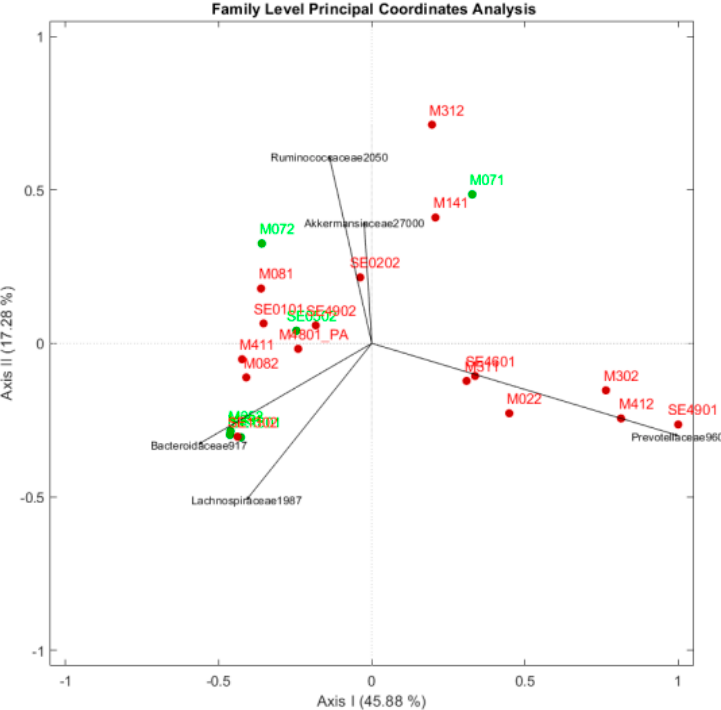
Figure 6. Beta diversity analyses at the family level: PCoA based on Bray–Curtis distance measure. Green: OSA − atherosclerosis. Red: OSA + atherosclerosis.